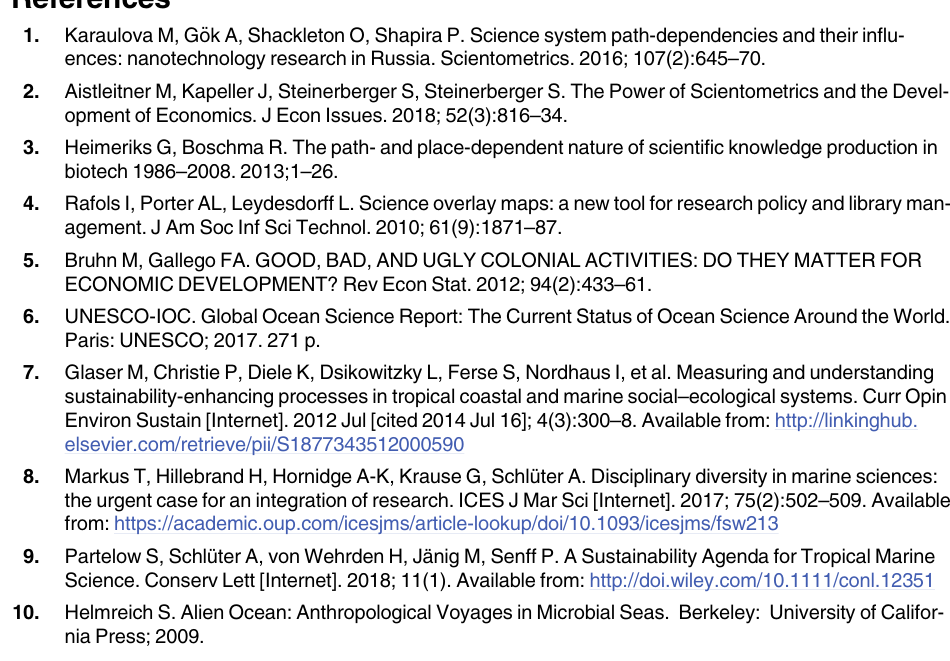
S6 Table. Network metric definitions. S7 Table. Unique collaborations with other